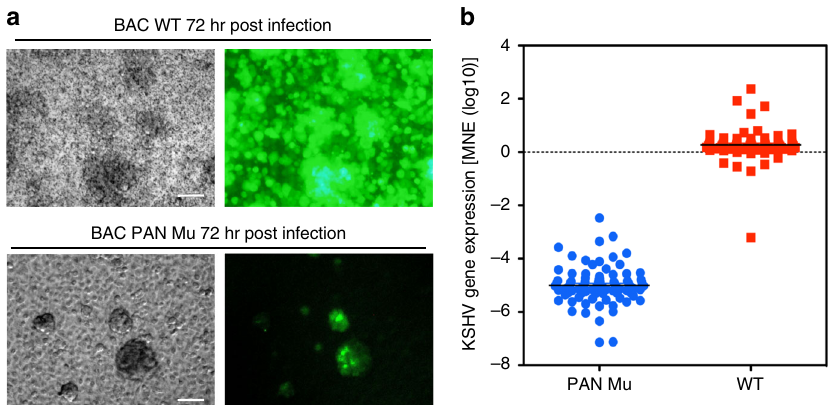
Fig. 7 Effects on de novo infection. a Primary HGEP cells were cultured in trans-well and infected with concentrated viral supernatants from BAC16 WT or PAN Mu cultures at 50 viral DNA copies/cell. eGFP expression was captured 72 h post-infection. Phase contrast (left panels) and eGFP (right panels) are shown. Exposure time for image capture for eGFP was set to 3.11 s. Scale = 100 μ m. b KSHV gene expression 72 h post-infection. KSHV gene expression was measured by KSHV PCR arrays and results were summarized as a box plot. Each point in the plot represents a KSHV ORF (PAN Mu, blue circles; WT,